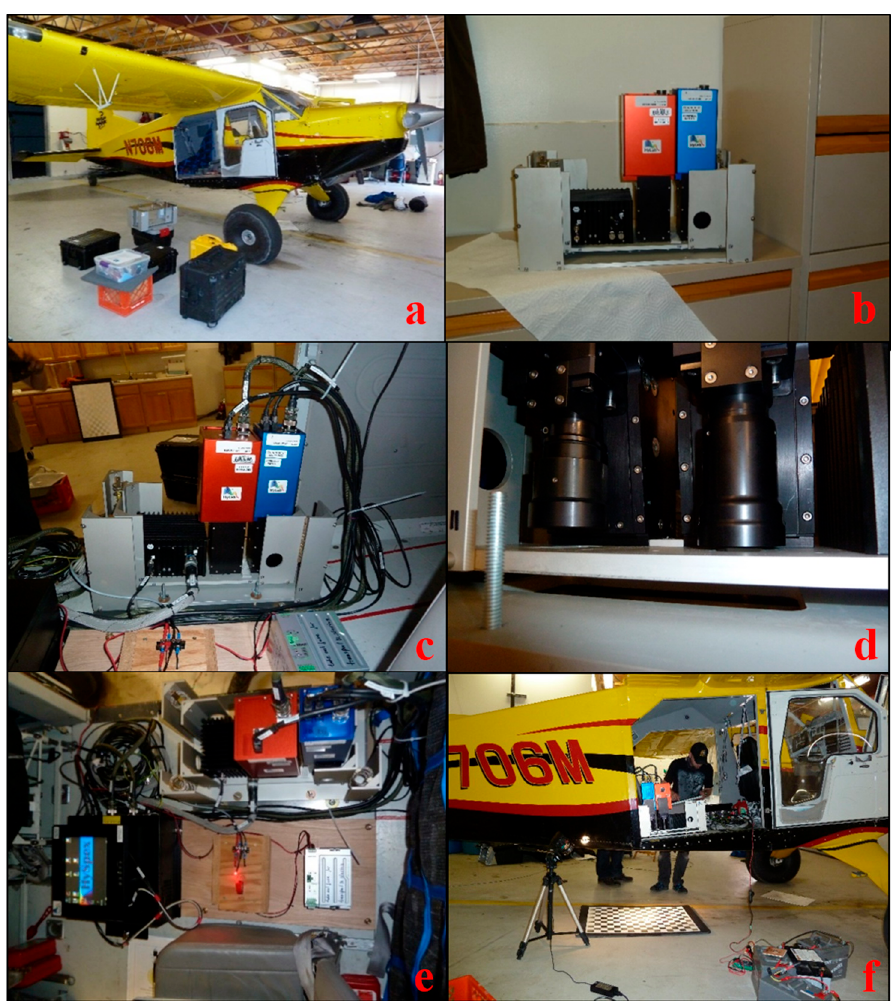
Figure 2. Commissioning the HySpex system for airborne acquisition. ( a ) Refuge Found Bush Hawk; ( b ) VNIR-1800, SWIR-384, and IMU/GPS units mounted to vibration dampening plate; ( c ) field of view expander optic attached to VNIR-1800 and SWIR-384 sensors; ( d ) detail of HySpex sensors in aircraft; ( e ) overhead view of the system secured and operating in aircraft; ( f ) testing system visibility through floor aperture of the aircraft.